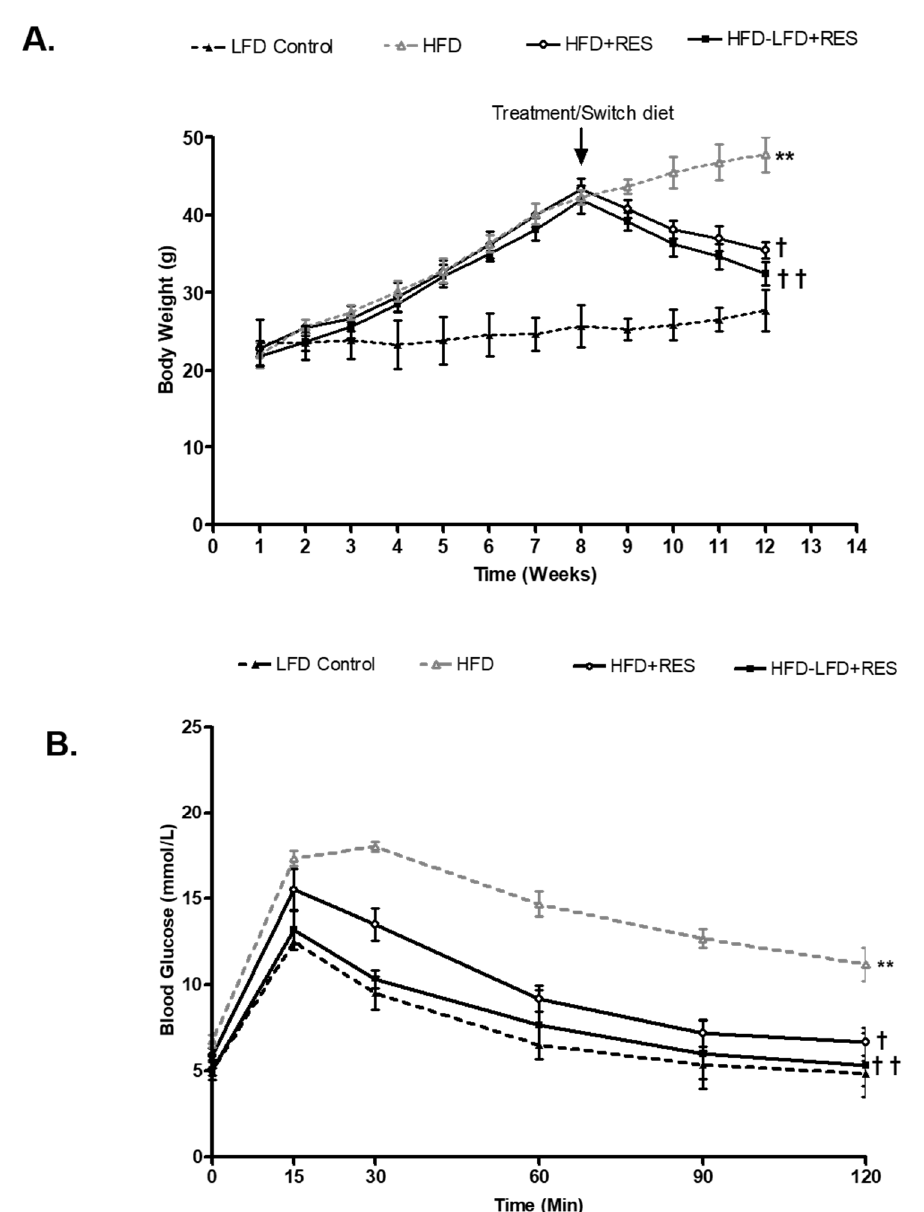
Figure 1. Effect of a low-fat diet and resveratrol treatment on weight gain and glucose tolerance in obese mice. ( A ): Body weight (g) over the 12-week study protocol in LFD control, HFD, HFD and RES, and HFD-LFD+Res groups. ( B ): Glucose tolerance at 12 weeks in LFD control, HFD, HFD and RES, and HFD-LFD+RES groups. ** p < 0.01 vs. LFD control; † p < 0.05; †† p < 0.01 vs. HFD. Values represents mean ± S.E.M. (n = 6–8).